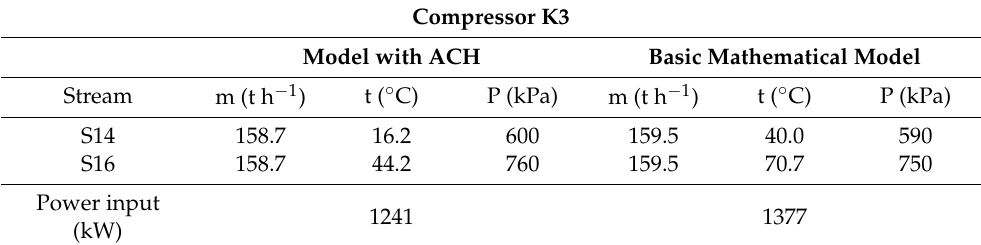
Table 7. Comparison of key parameters related to compressor K3 obtained by basic ASU model and by model comprising ACH.